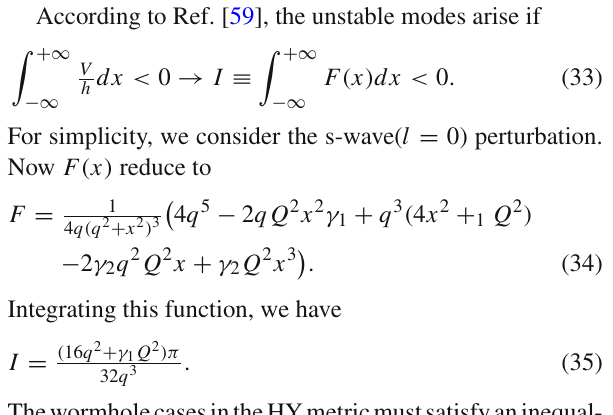
Fig. 7 Time-domain profiles with the same parameters with Fig.